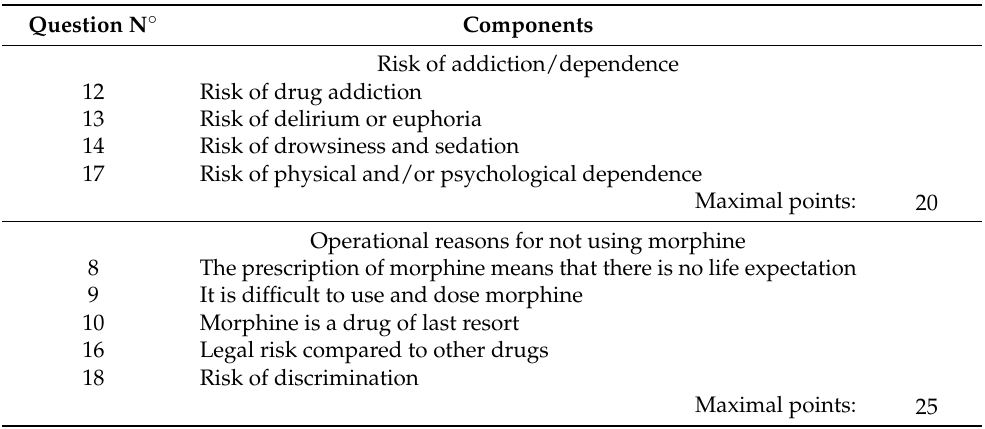
Table A1. Question numbers included in each of the 5 subscales of the Attitude Towards Morphine Score (ATMS) and their total